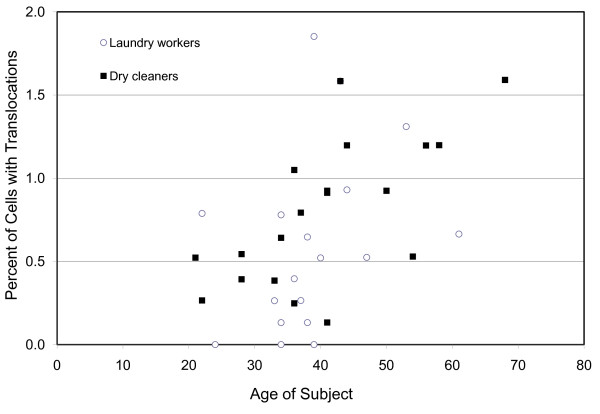
Translocation frequencies by age in dry cleaners and laundry workers. A highly significant effect of age is apparent (R2 = 0.52; p = 0.0012).